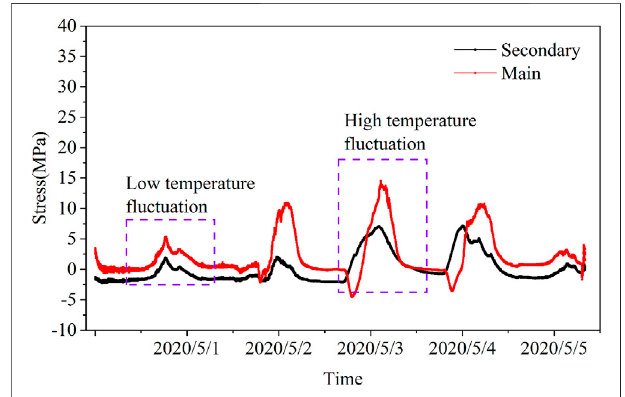
FIGURE 9 | The stress course of rods in different